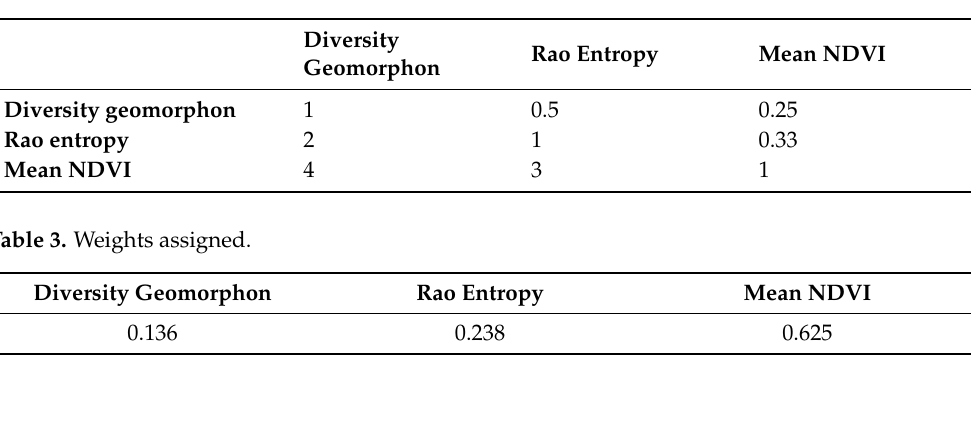
Table 2. Saaty AHP matrix.